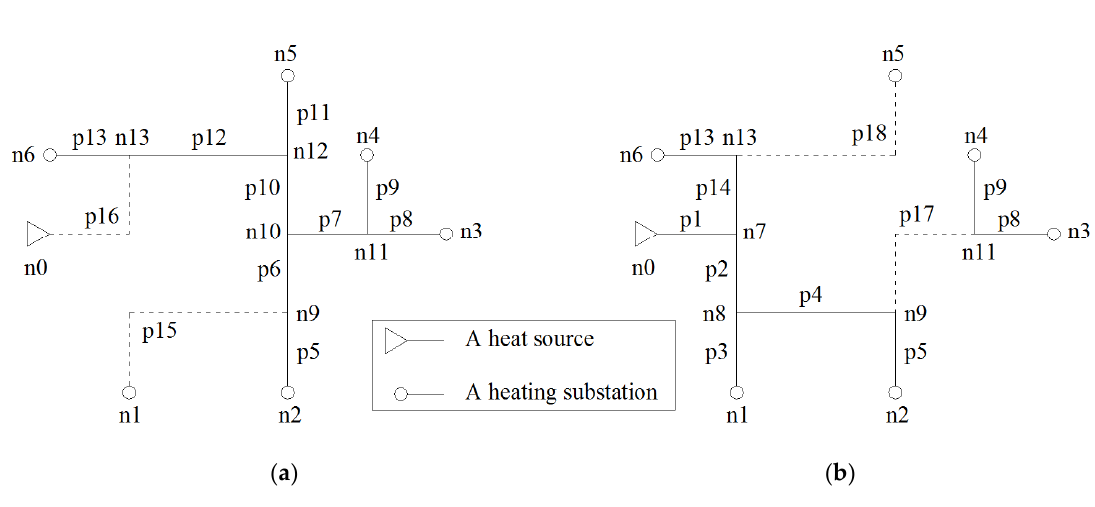
Figure 5. Shutting scheme of the example loop DHN. ( a ) BN 1; ( b ) BN 2.